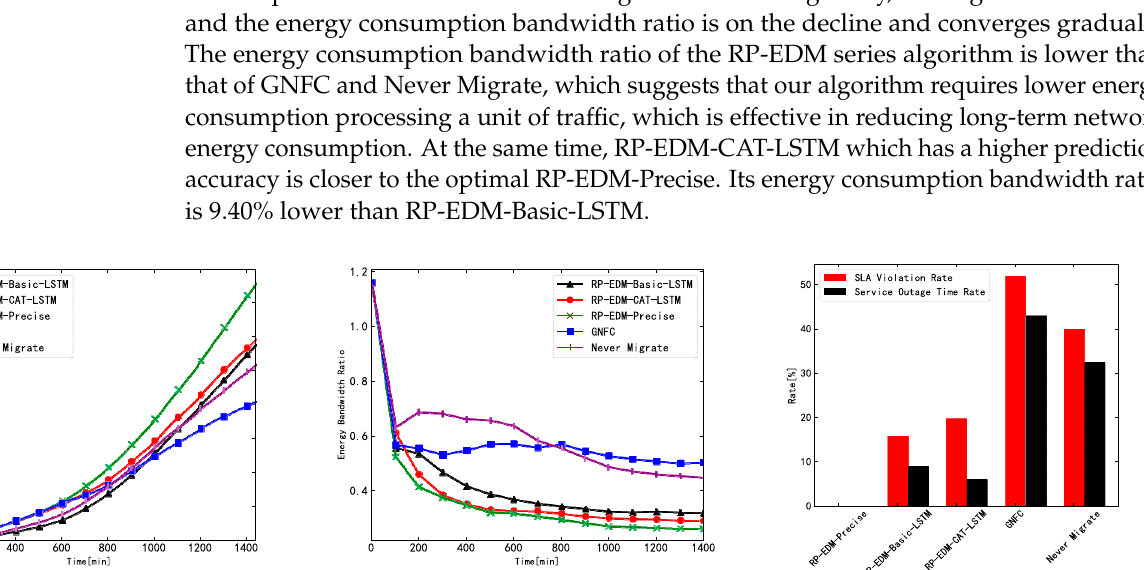
Table 2. Comparison of the results of CAT-LSTM and basic LSTM averaged across all VNFs from SFCs, for the number of RNN units = 80, learning rate = 0.001, the max number of iterations = 800 with early stop, prediction time = 5 s, amount of historical data = 15 s.